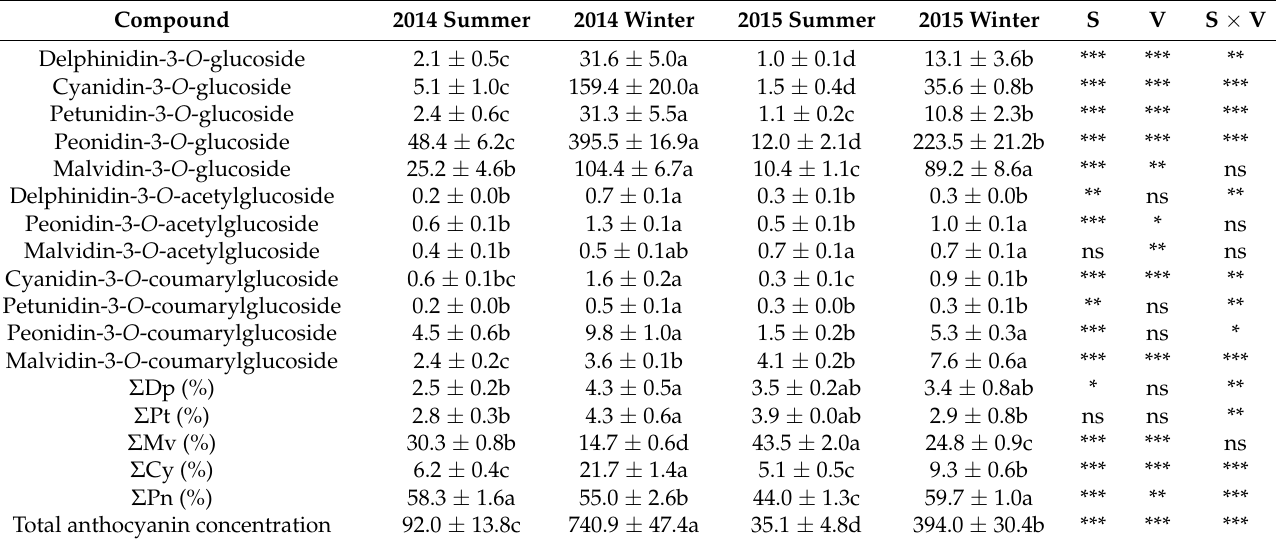
Table 2. Anthocyanin concentration (mg/kg FW) in ‘Muscat Hamburg’ grapes in 2014 and 2015 under the double cropping